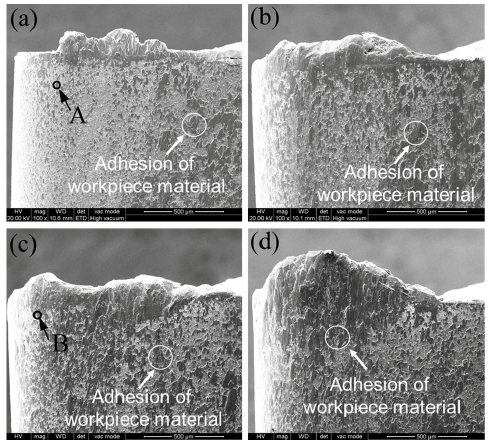
Figure 13. Wear of the flank face using UCI: ( a ) CT; ( b ) 0.42 A/mm 2 ; ( c ) 0.57 A/mm 2 ; and ( d ) 0.90 A/mm 2